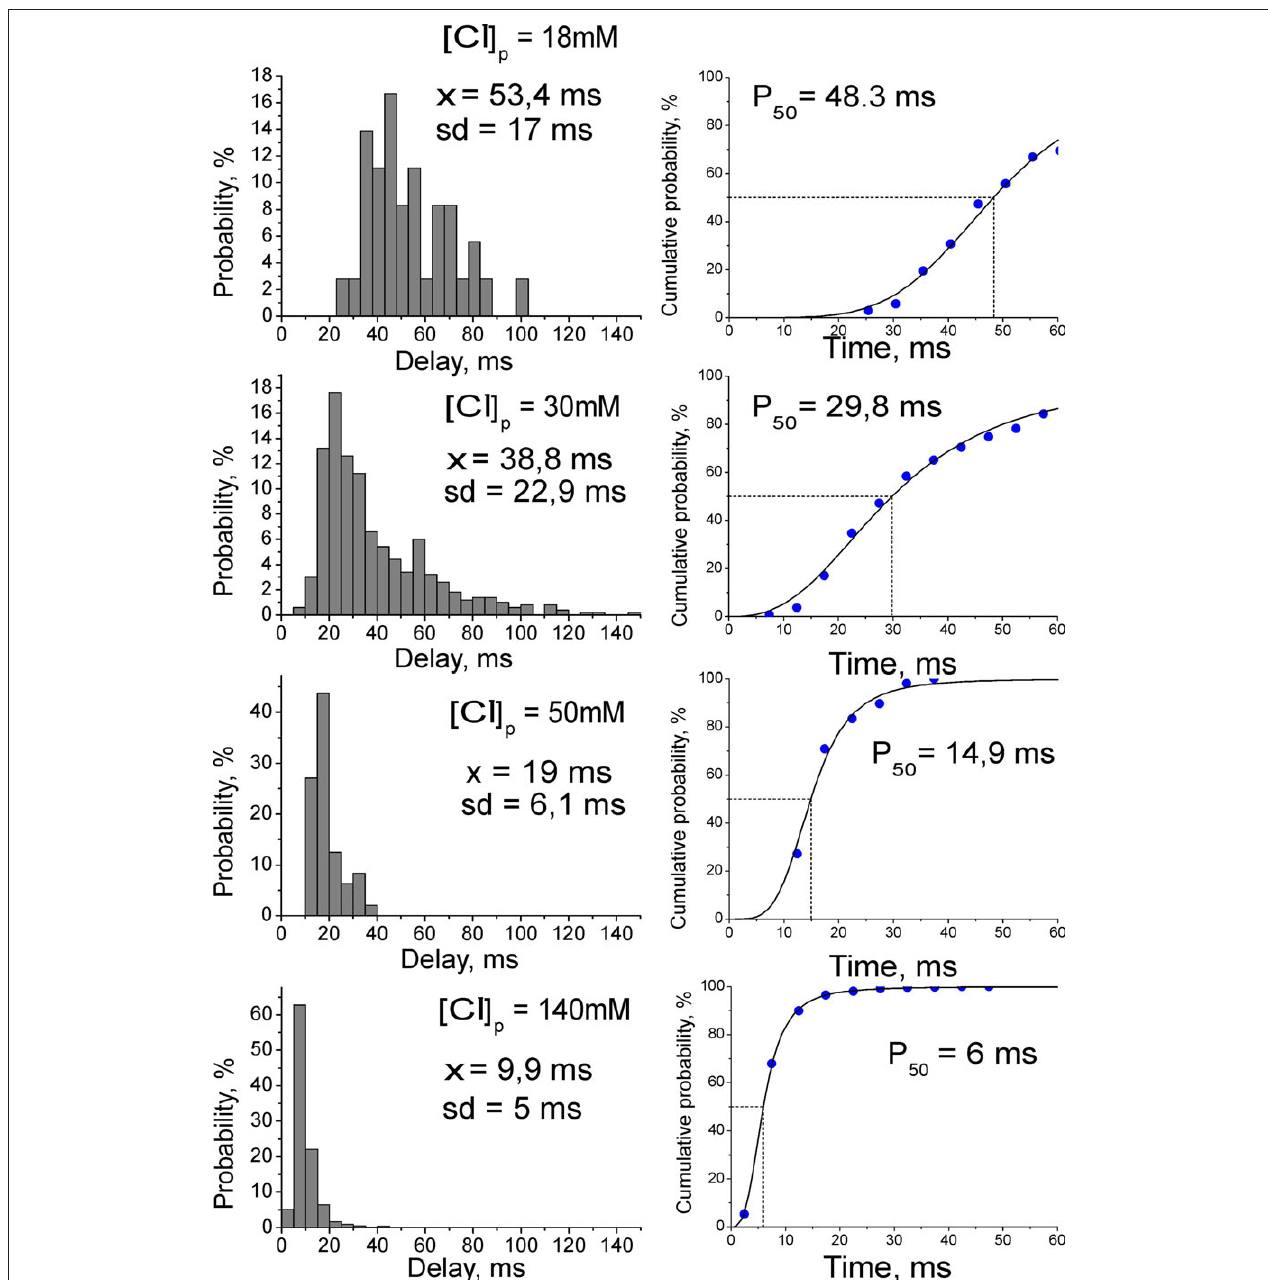
Figure 3 | Dependence of spike timing at gABAergic synapse on intracellular chloride concentration. Left: Average histograms of the AP delays at different [Cl - ] in whole-cell recordings. Right: Cumulative curves for the AP delays fitted by Hill p